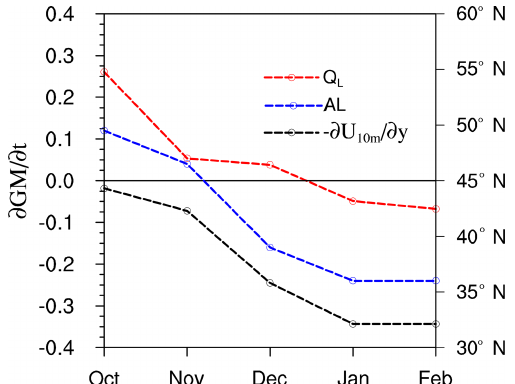
Figure 10. Meridional gradient of 10m wind speed ( − ∂U 10m /∂y , black, units: 10 − 5 s − 1 ) and GM tendency calculated by the la- tent heat flux ( Q L , red, units: ◦ C(100km) − 1 month − 1 ) over the NPSTF. The blue curve (AL) is the latitude of climatological geopo- tential height at 900m 2 s − 2 averaged zonally over 140 ◦ E–170 ◦ W, representing the southward migration of the Aleutian